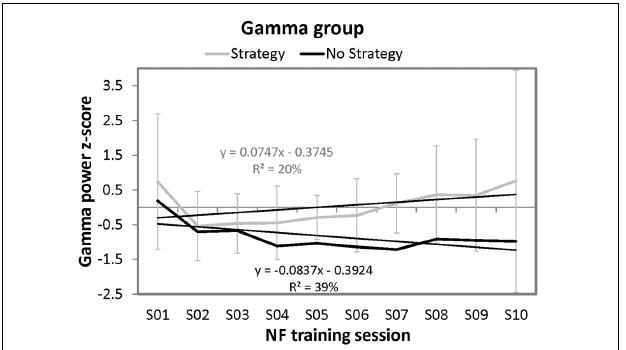
FIGURE 4 | Means and standard deviations of z -transformed Gamma (40–43Hz) power (NF performance) over the ten NF training sessions, presented separately for participants reporting to use a specific mental strategy in the tenth NF session (strategy group) and participants reporting no specific mental strategy in the tenth NF session (no strategy group) of the Gamma group and the results of the regression analyses. Note that only standard deviations for the strategy group are plotted since only one participant was present in the no strategy group.